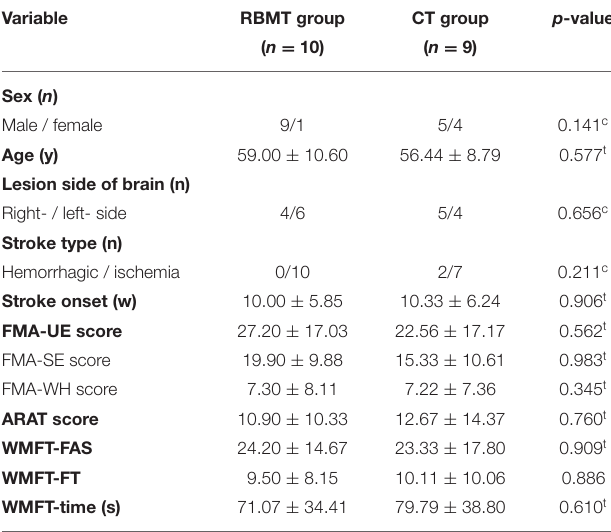
TABLE 1 | The summary of participant’s